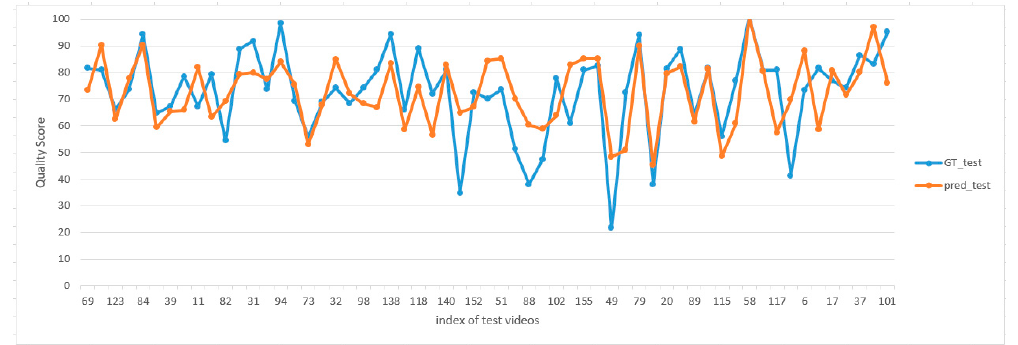
Figure 7. The predicted scores of test videos from our best rank correlation coefficient for the MIT diving dataset.